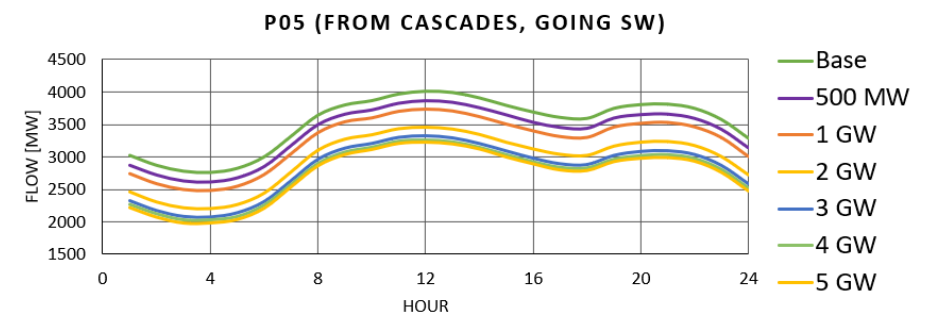
Figure 11. Impacts on daily hourly average flows for each hour of the year from OSW integration on Path 05, the transmission path from the Cascades and the Columbia River Gorge southwest into north/central-west Oregon. Positive direction is flow west.